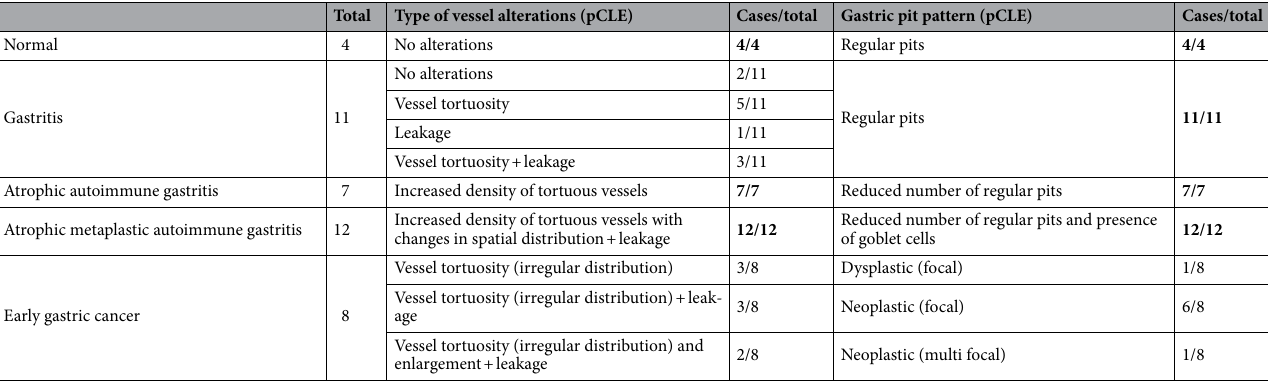
Total Type of vessel alterations (pCLE) Cases/total Gastric pit pattern (pCLE)